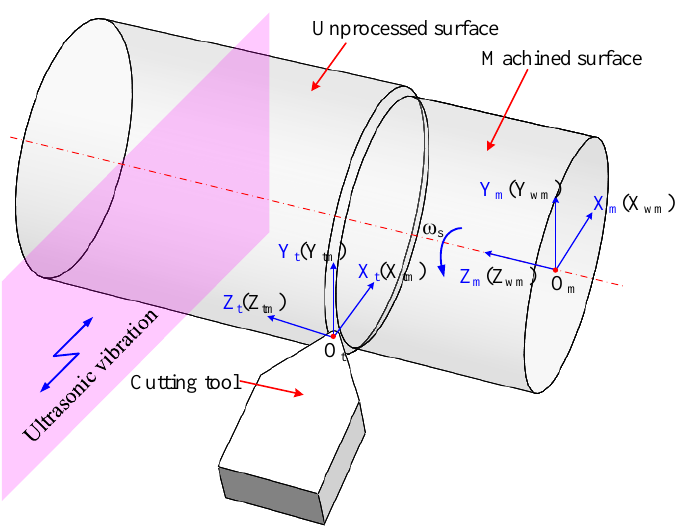
Figure 15. Illustration of the space coordinate transformation.